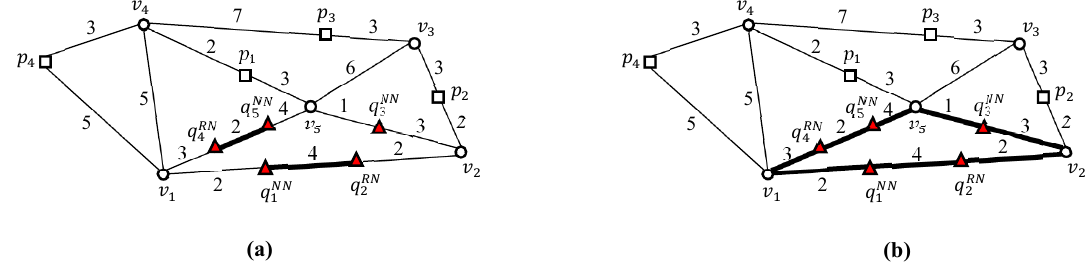
Figure 5. Clustering nearby query points into a query cluster: ( a ) connecting query points in a vertex sequence into a query segment. ( b ) Clustering adjacent query segments into a query cluster using joint